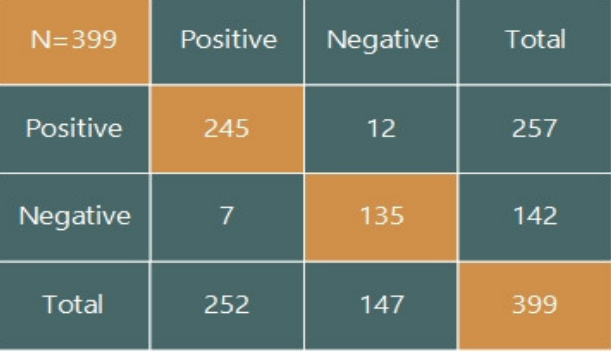
Figure 9. Confusion Matrix for the proposed system.